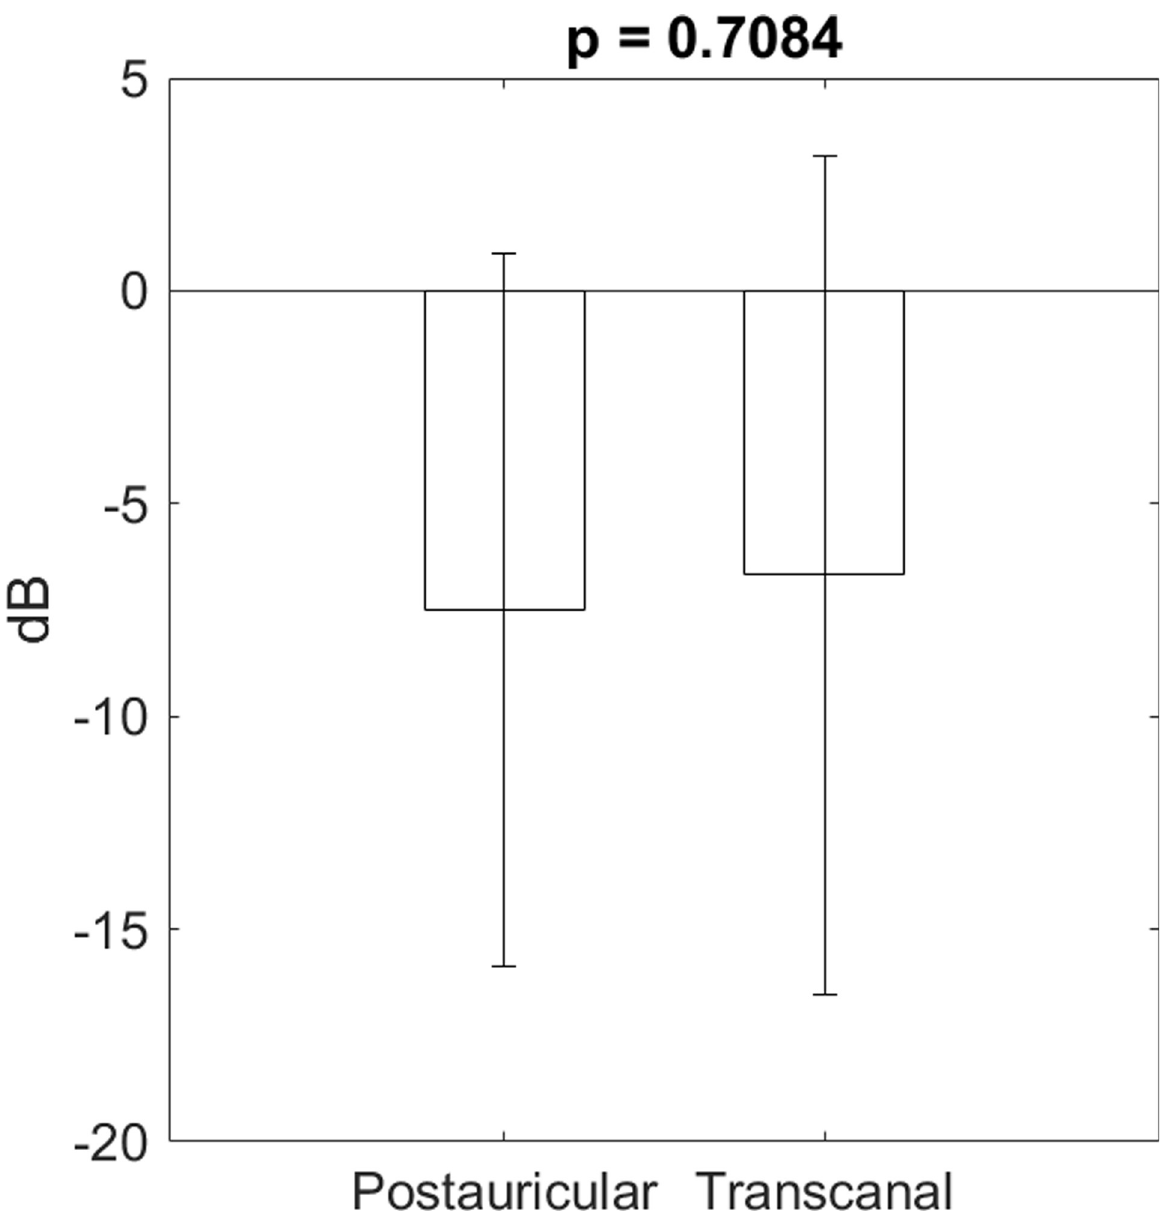
Fig 2. The mean changes of air-bone gap after the surgery in the postauricular group did not differ from those in the transcanal group.